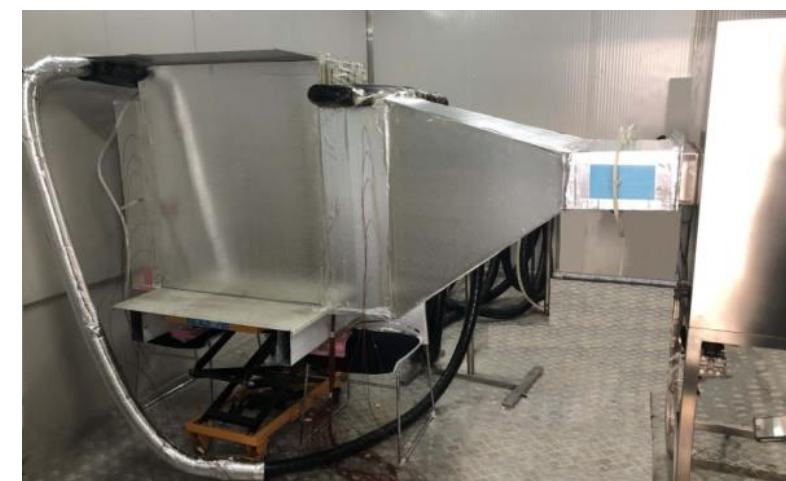
Figure 4. Photo of experimental system. Table 1. Information of experimental